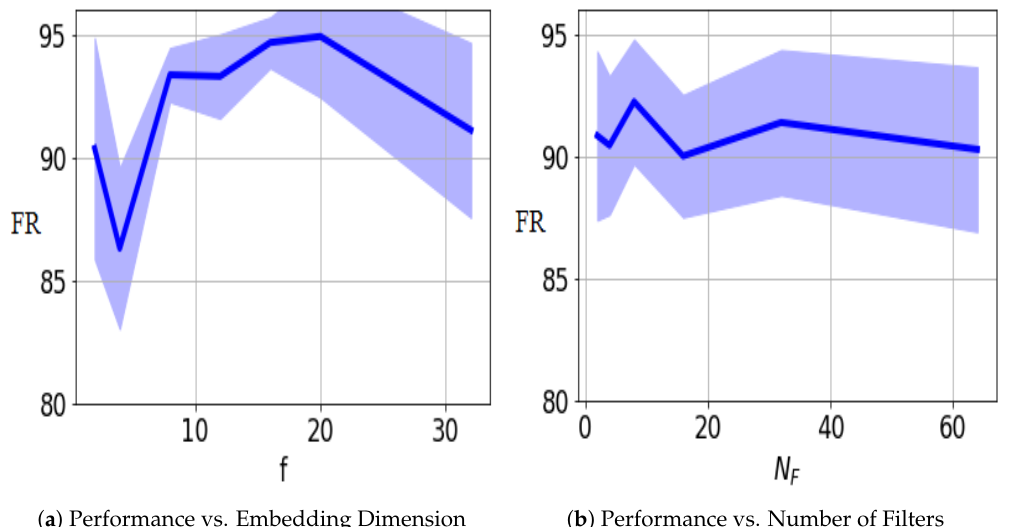
Figure 2. The SAR test performance versus the dimension of the embedding space and the number of